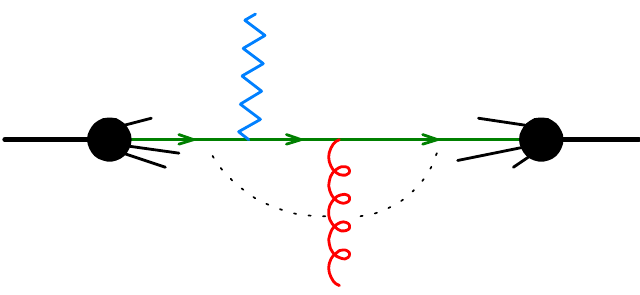
Figure 1 . Typical diagram contributing to the transverse momentum distribution of a Z boson, which is represented by a blue zigzag line. The soft radiation pattern (dashed line) is associated with the dipoles formed by the outgoing hard gluon (red curly line) and the initial state quarks, and is not azimuthally